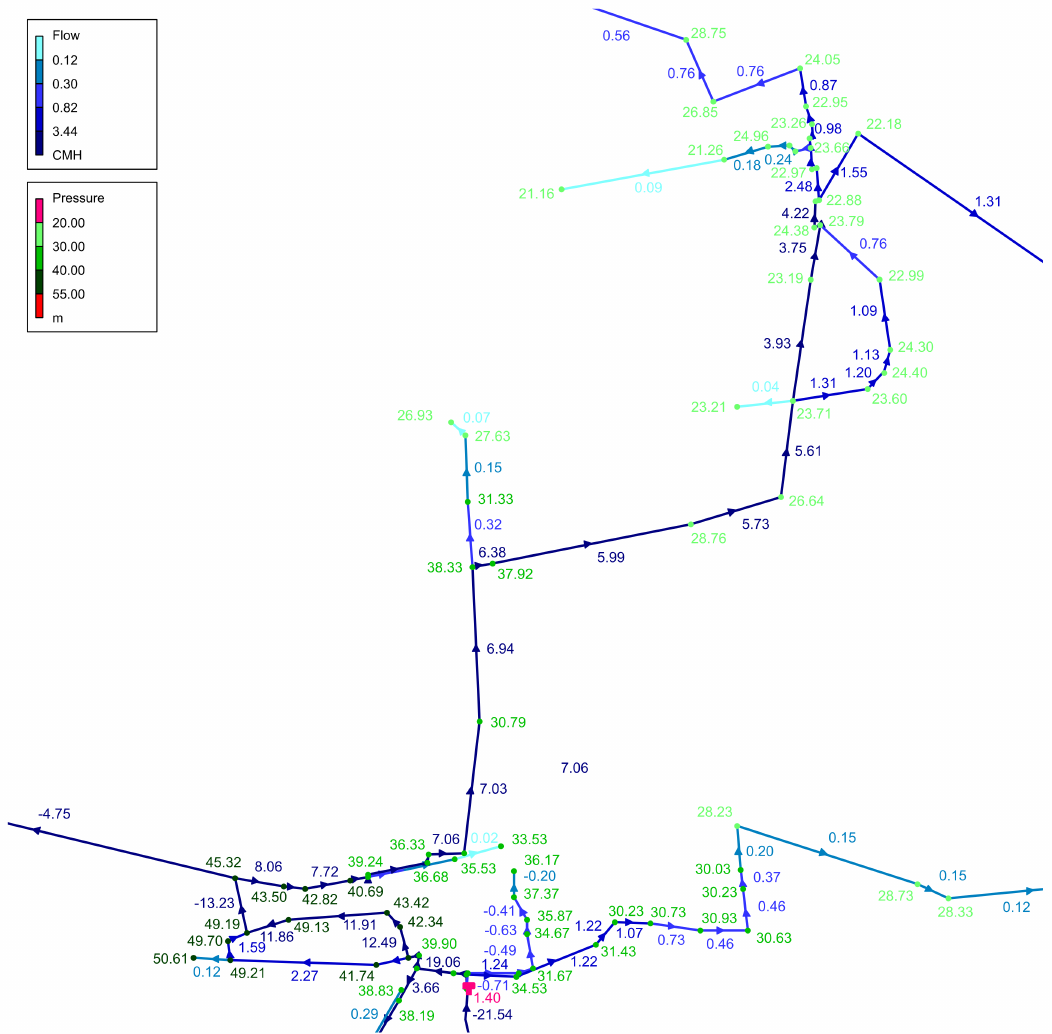
Figure 7. The pressure and flow rate for the average hourly water demand; zoomed view of the map on the central part of the